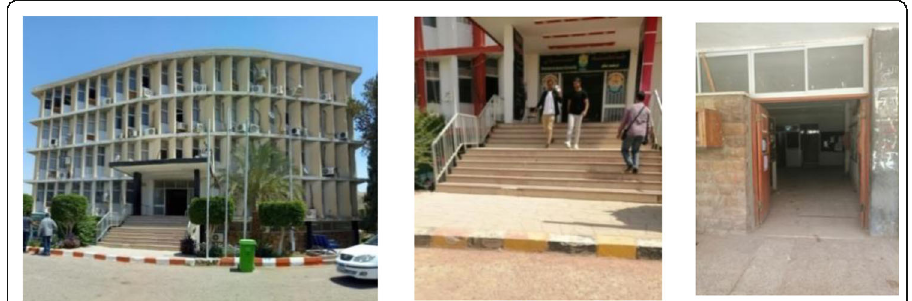
Fig. 10 The entrance is difficult to be used due to lack of ramps and guiding blocks